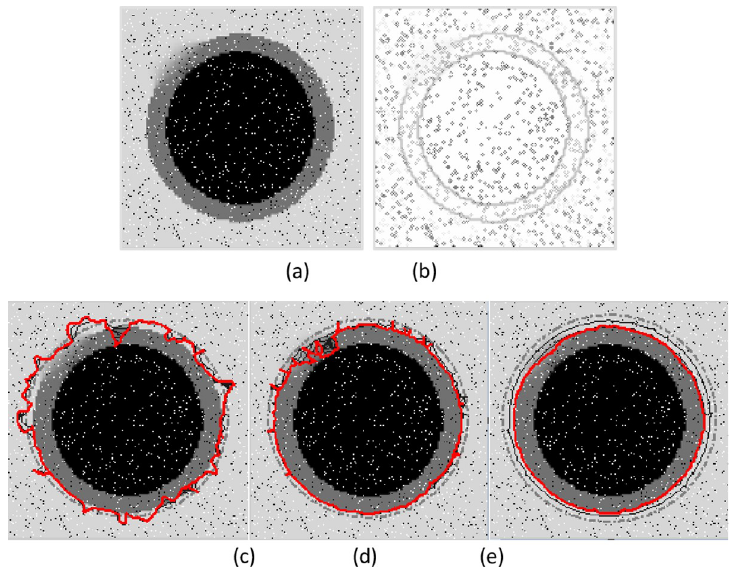
Fig 6. Example of weak edge preservation and noise suppression. (a) The noisy image,(b) edge map, segmentation results of (c) the GVF snake with μ = 0.1, (d) the VEF snake, and (d) the MCONVEF snake with k = 0.1, h = 1.2 and L = 2. The gray dash point circles are the initial contours, and the solid lines in red are the converged results.